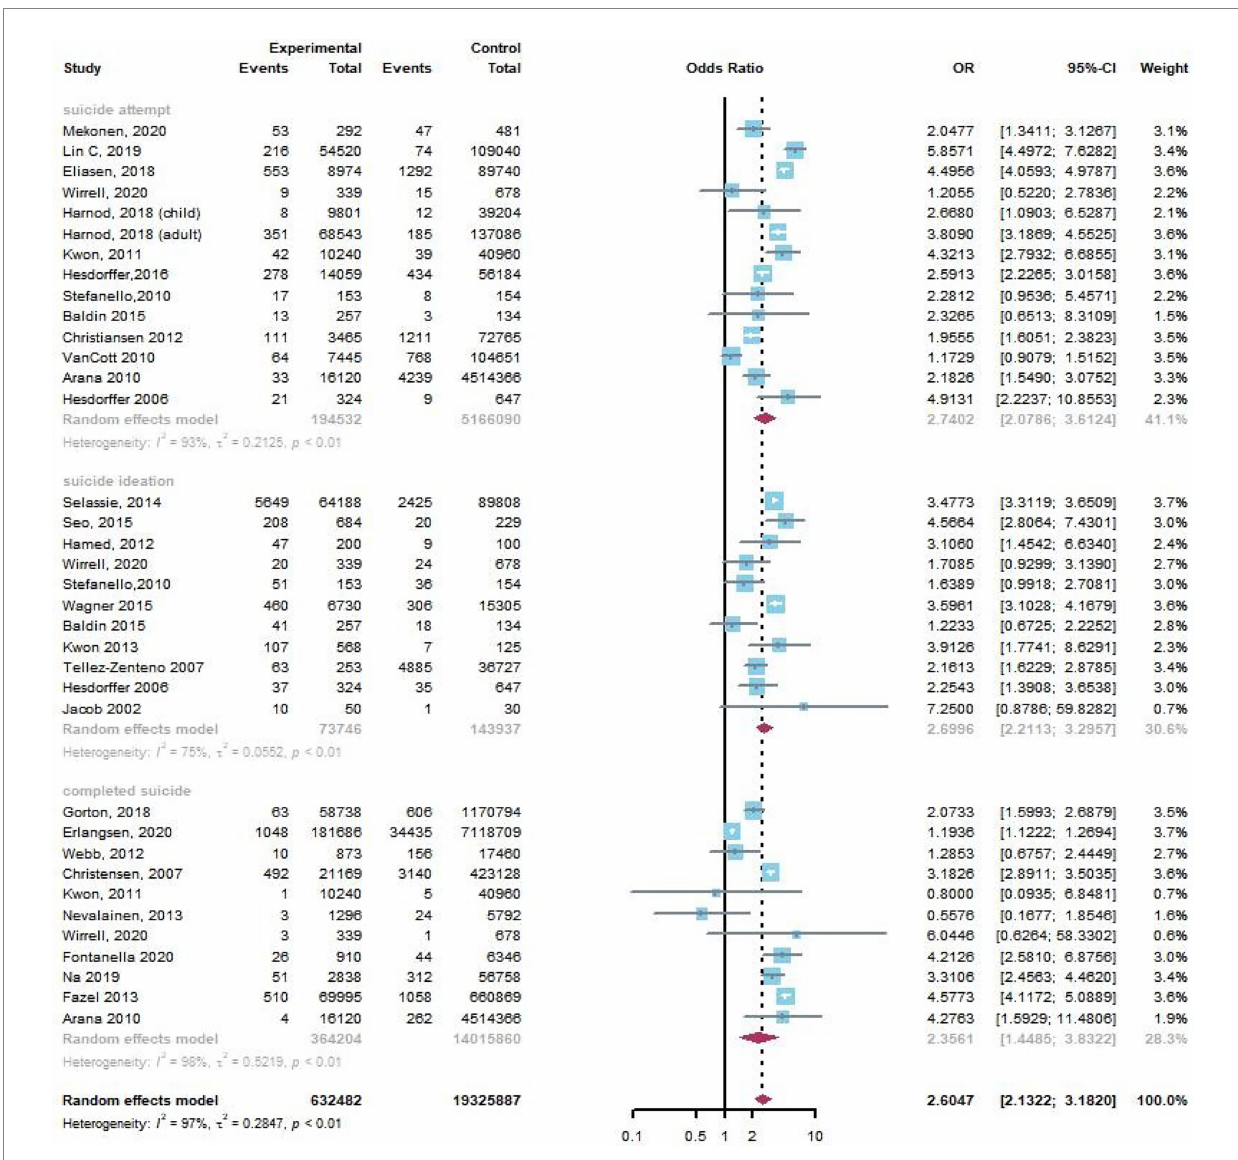
FIGURE 2 The risk of suicidality between patients with epilepsy and